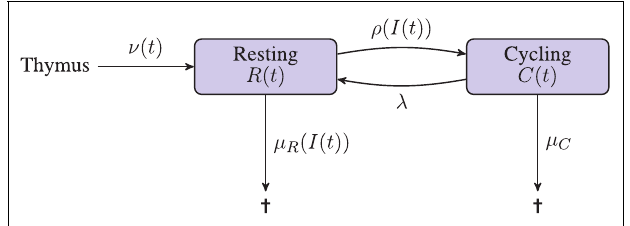
FIGURE 1 | Diagrammatic illustration of the deterministic model .T cells leaving the thymus enter the resting naive peripheral pool. Cells in either a resting or cycling state may die.The rate of death from the resting state depends on the availability of the resource (IL-7), whereas the death rate for cycling cells is constant. Resting cells enter the cell cycle at a rate that depends on the availability of the resource (IL-7). Cycling cells produce two daughter cells in the resting state upon completion of the cell